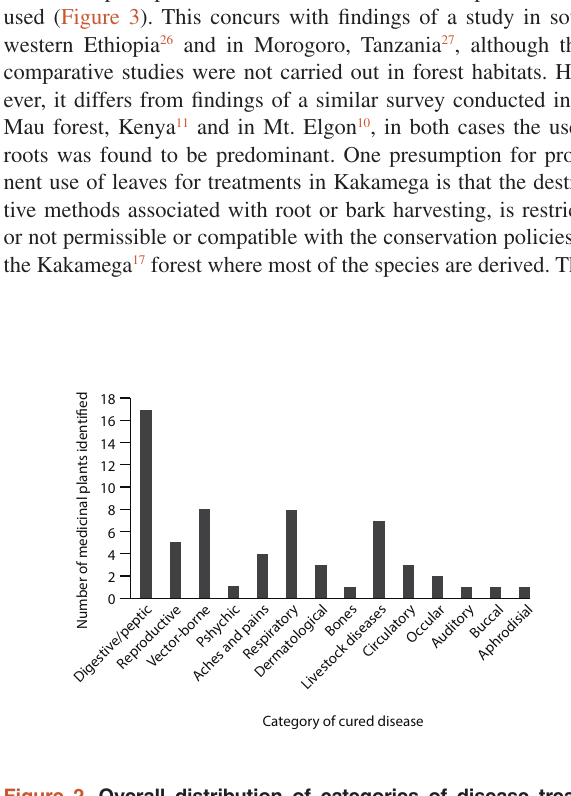
Figure 2. Overall distribution of categories of disease treated using medicinal plants